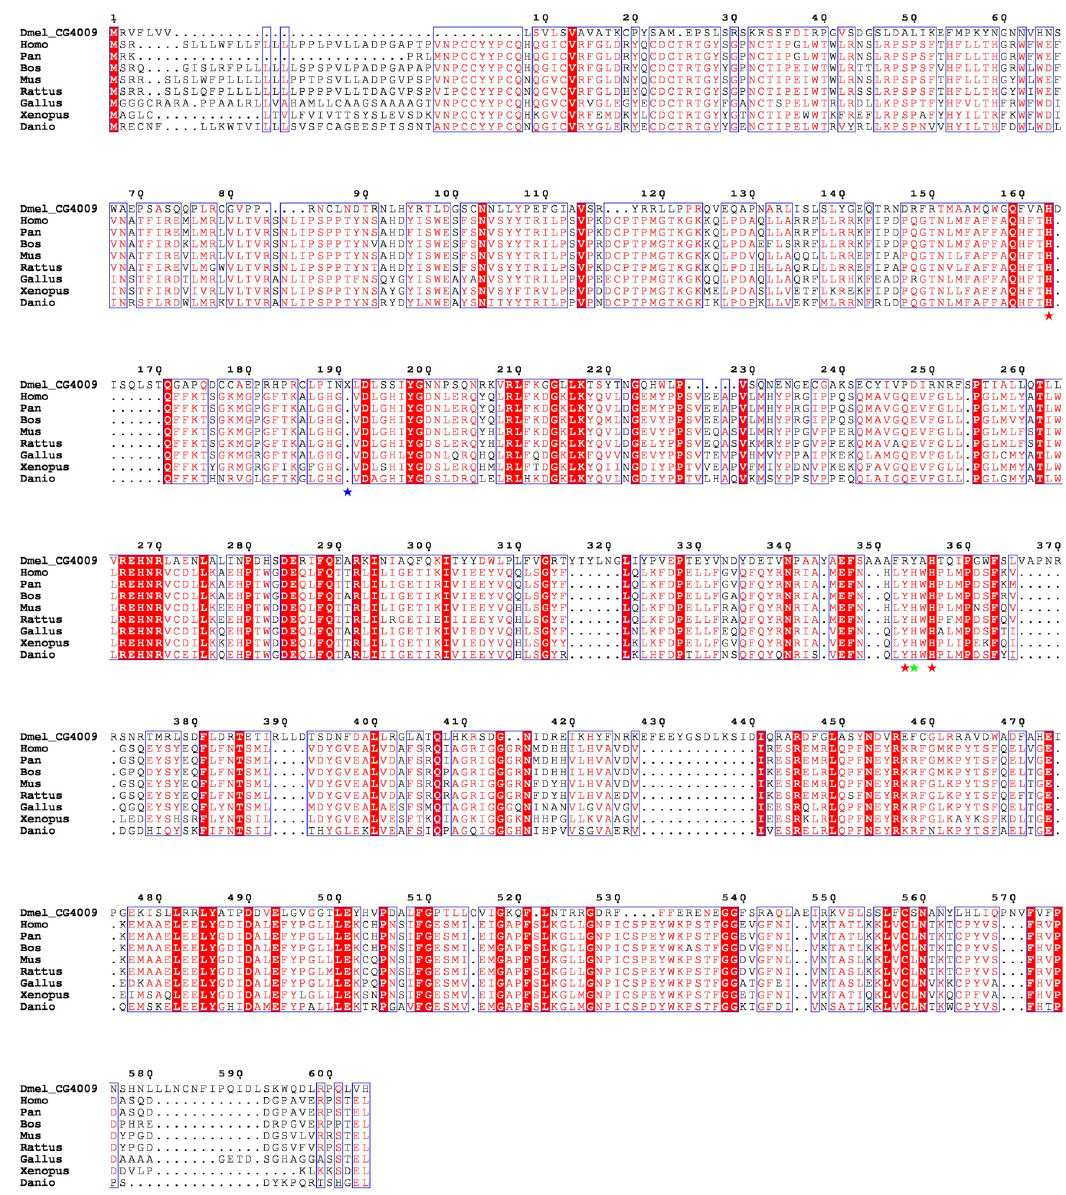
Fig 2. A multiple sequence alignment of the D . melanogaster candidate CG4009 with human PTGS1 and known or high confidence predicted orthologs. Red asterisks below the MSA denotes conserved key catalytic residues. The green asterisk marks the putative analog for the tyrosine. The blue asterisk denotes an insertion of 42 residues in CG4009 and reads X in the